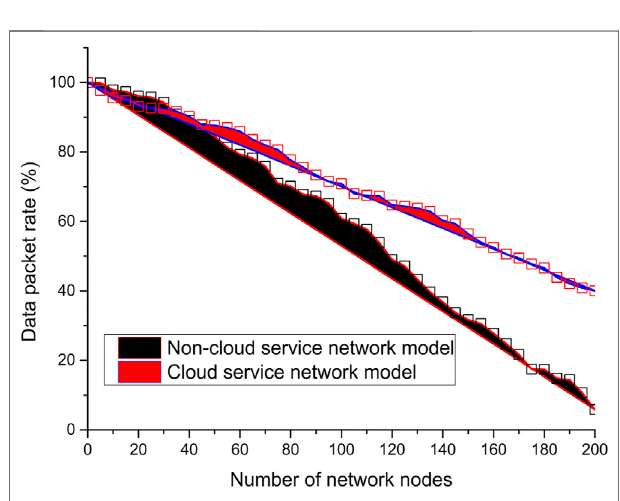
FIGURE 12 | Analysis and comparison of packet delivery